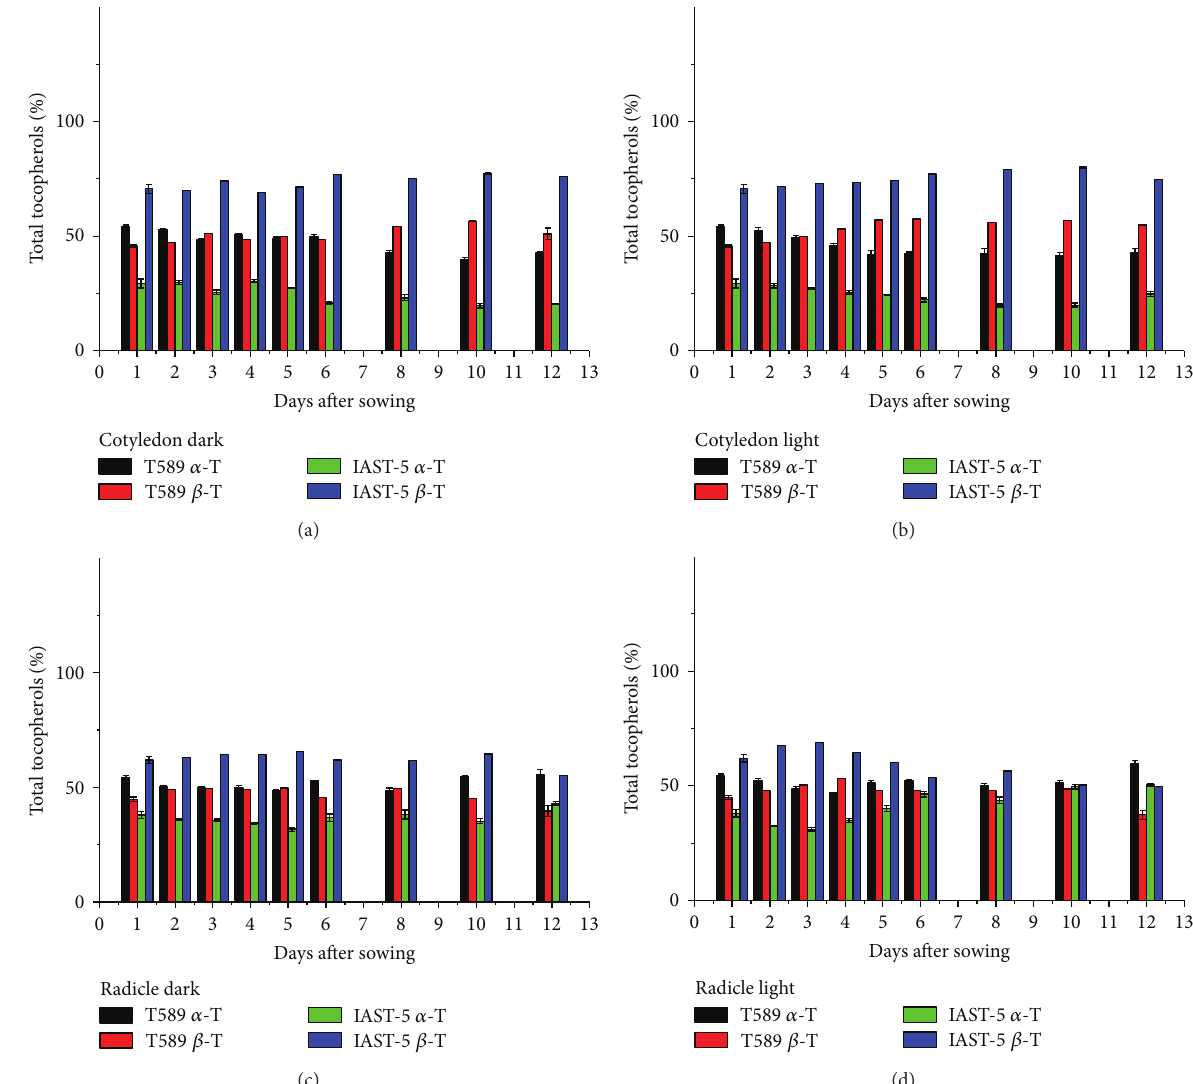
Figure 4: Proportion of 𝛼 - and 𝛽 -tocopherol (% total tocopherols) from 1 to 12 days after sowing in cotyledons and radicles of sunflower lines T589 and IAST-5, with different increased levels of 𝛽 -tocopherol, from seedlings grown under dark and light conditions. Data are presented as mean ± standard error of three